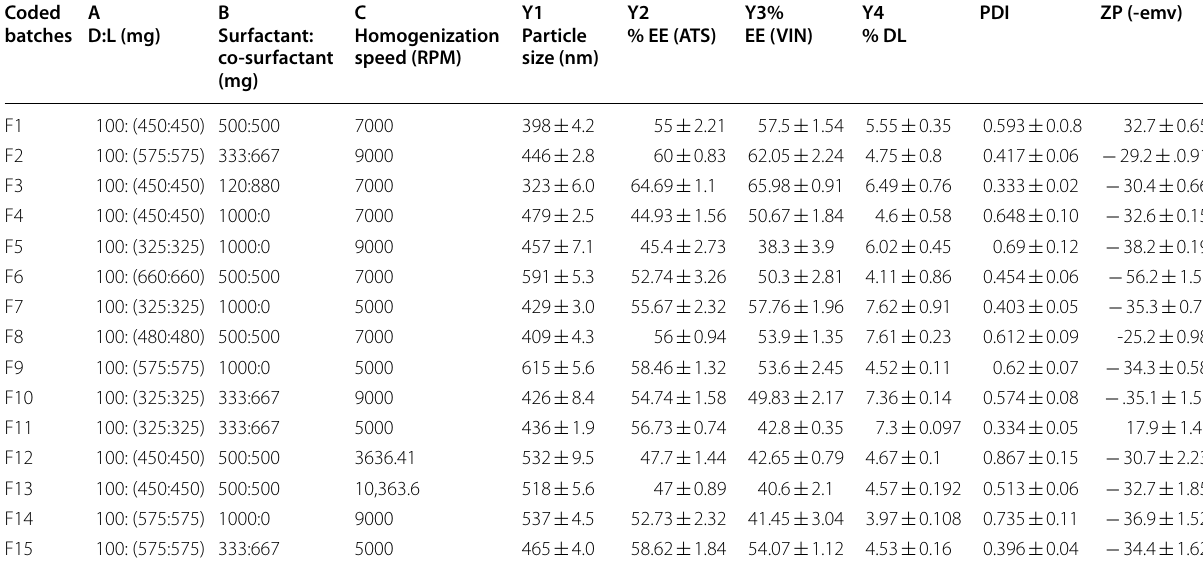
Optimized coded batches: F1–F15, amount of poloxamer (used as a stabilizer)-200 mg, ratio of lipid- mixture used (GMS: Precirol ATO 5)—1:1, total amount of surfactant and co-surfactant mixture (Tween 80 and Labrasol)—1000 mg